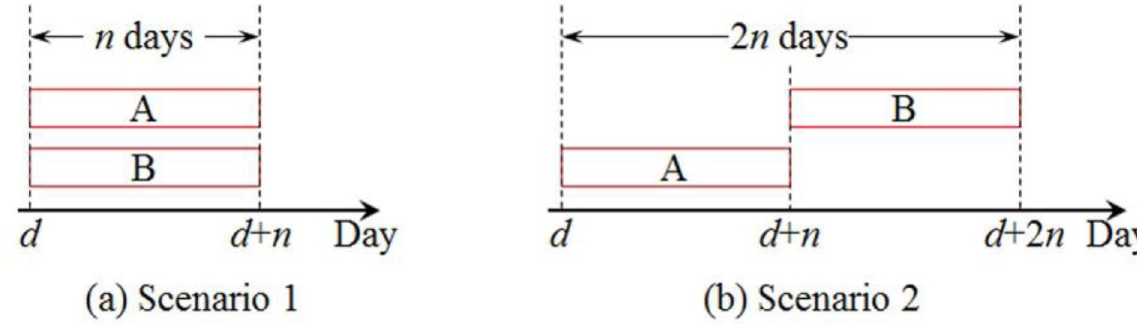
Fig 2. Two scenarios of highway maintenance